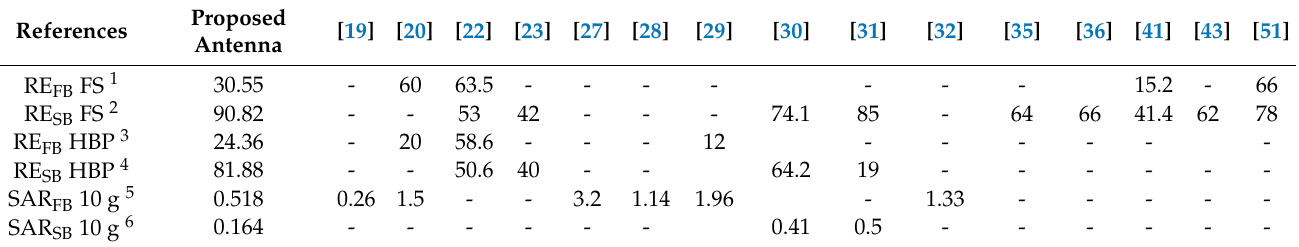
Table 5. Comparison of the proposed